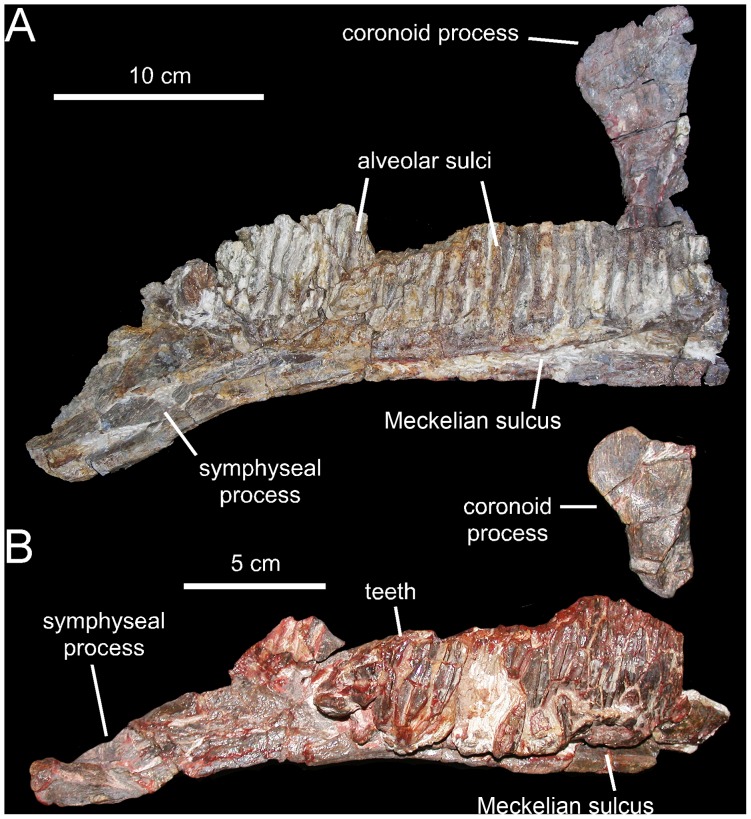
Indeterminate lambeosaurine elements collected at the Basturs Poble bonebed.A. Right dentary (MCD 5007) in medial view. B. Right dentary (MCD 4743) in medial view.